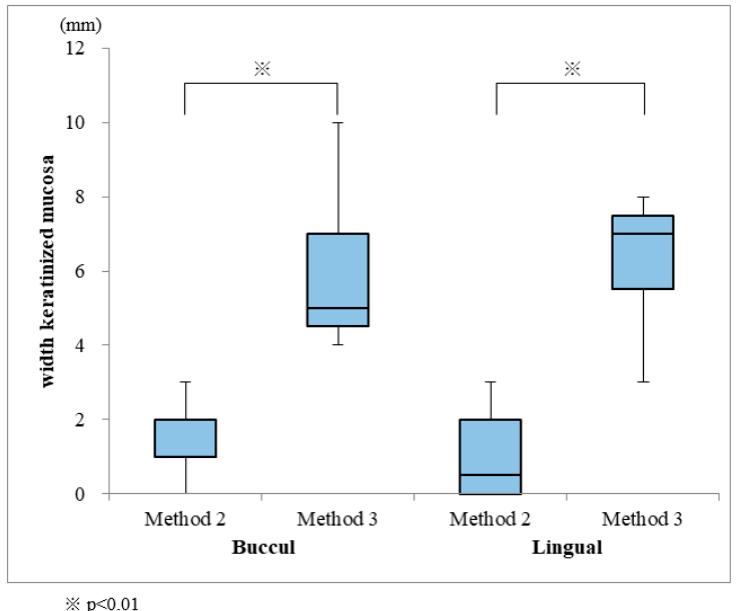
Figure 7. Comparison of keratinized mucosa widths obtained from Methods 2 and 3.